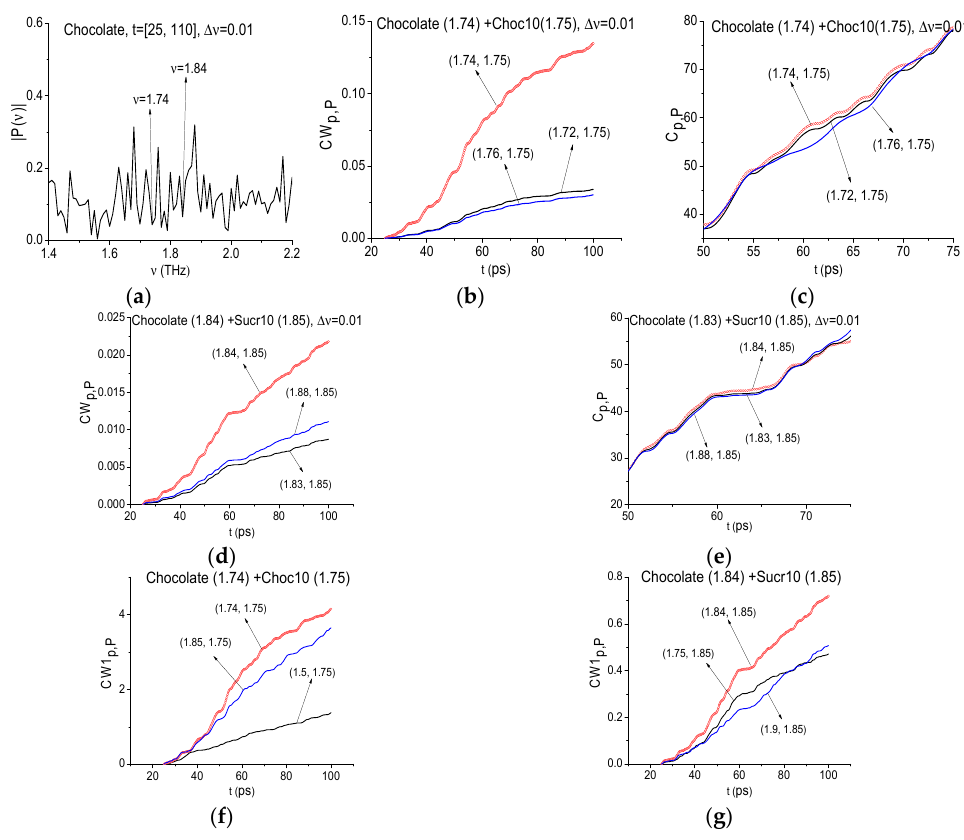
Figure 14. Chocolate signal spectrum ( a ) in the frequency range ν = [1.4, 2.2] THz calculated in the time interval t = [25, 110] ps with the spectral resolution Δ ν = 0.01 THz. The ICC’s CW p,P ( b , d ), C p,P ( c , e ), CW1 p ,P ( f , g ) evolution, calculated for frequencies ν = 1.74 THz ( b , c , f ), 1.84 THz ( d , e , g ) for the signal Chocolate and Choc10 ( b , c , f ), Sucr10 ( d , e , g ) as the standard signals. We see in Figure 14b,c that the line corresponding to the ICC C p,P calculated for the chocolate absorption frequency ν = 1.74 THz (c) lies above other lines in the time interval t = [50, 75] ps. Therefore, in this time interval the excitation of the corresponding energy transition takes place. Also by using the standard signal Sucr10, the frequency ν = 1.84 THz is detected as the sugar absorption frequency in the signal Chocolate, see Figure 14d,e. The criterion L p,P evolution in Figure 14 is not shown because the corresponding lines are almost coincide with each other for the considered FDRs ν = [1.72, 1.76] THz (b), (c) and ν = [1.83, 1.88] THz (d), (e). The evolution of ICC CW1 p ,P (f), (g) confirms this result.